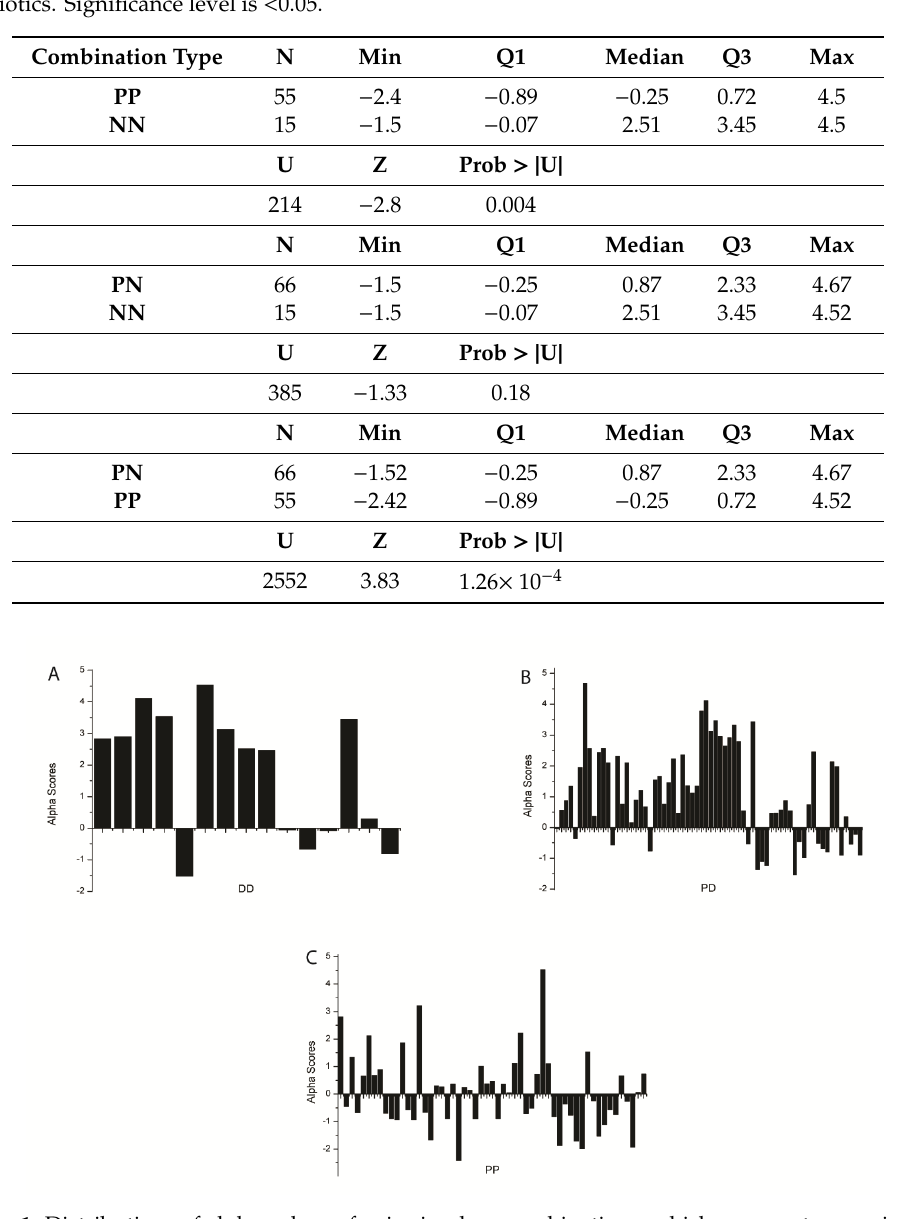
Figure 1. Distributions of alpha values of pairwise drug combinations, which represent synergistic or antagonistic interactions. Negative values show synergistic interactions whereas positive values show antagonistic interactions of combinations of ( A ) nucleic acid synthesis inhibitors (NN), ( B ) combinations of both nucleic acid synthesis and protein synthesis inhibitors (PN), and ( C ) protein synthesis inhibitors (PP).